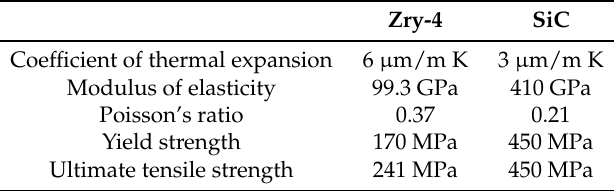
Table 2. Properties of zircaloy-4 (Zry-4) and silicon carbide (SiC).